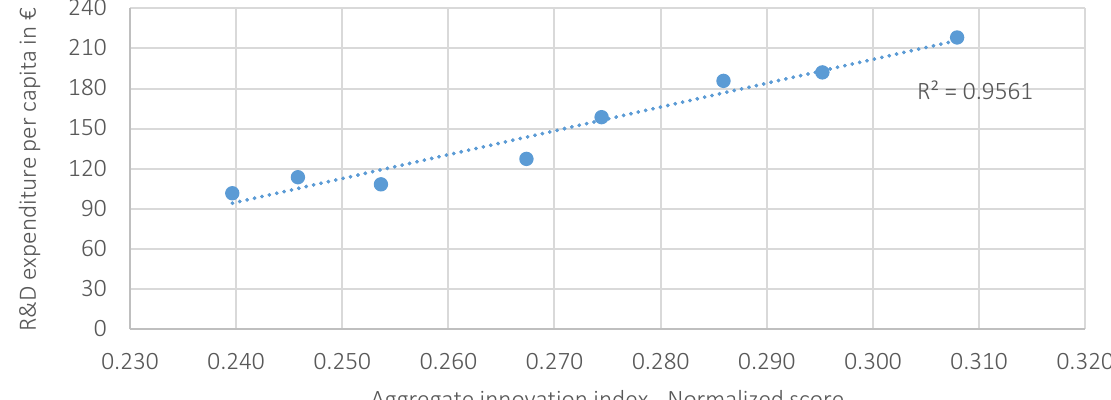
Figure 4. Correlation analysis – Poland